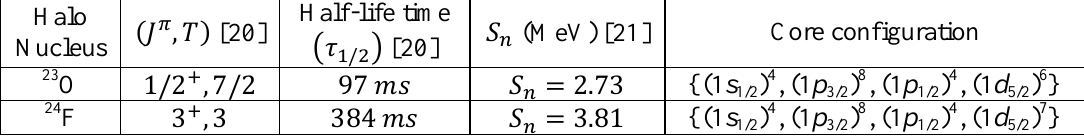
Table 1: Some features for the considered nuclei.